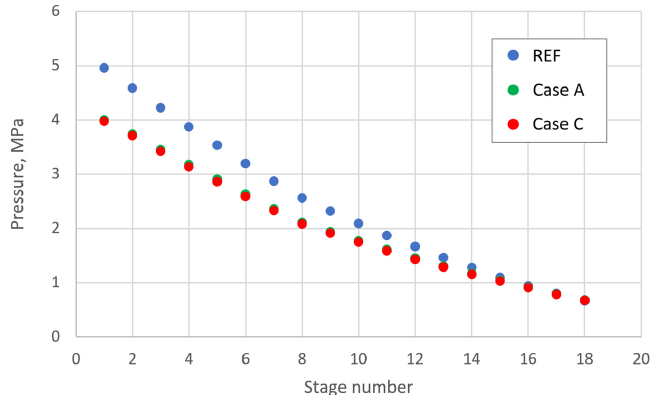
Figure 3. Pressure distribution calculation in the IP section of the turbine.